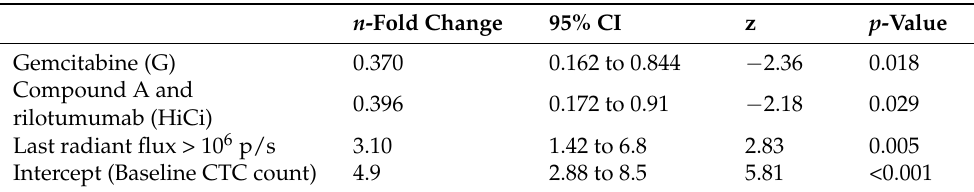
Table A7. Model specification for Figure 4d: Poisson regression model of CTC counts versus treatments. This model assesses the effects of treatments on CTC counts, taking into account the last measured tumour burden (assessed by bioluminescence imaging). Note: The interaction term was dropped as it was not statistically significant. n -Fold Change